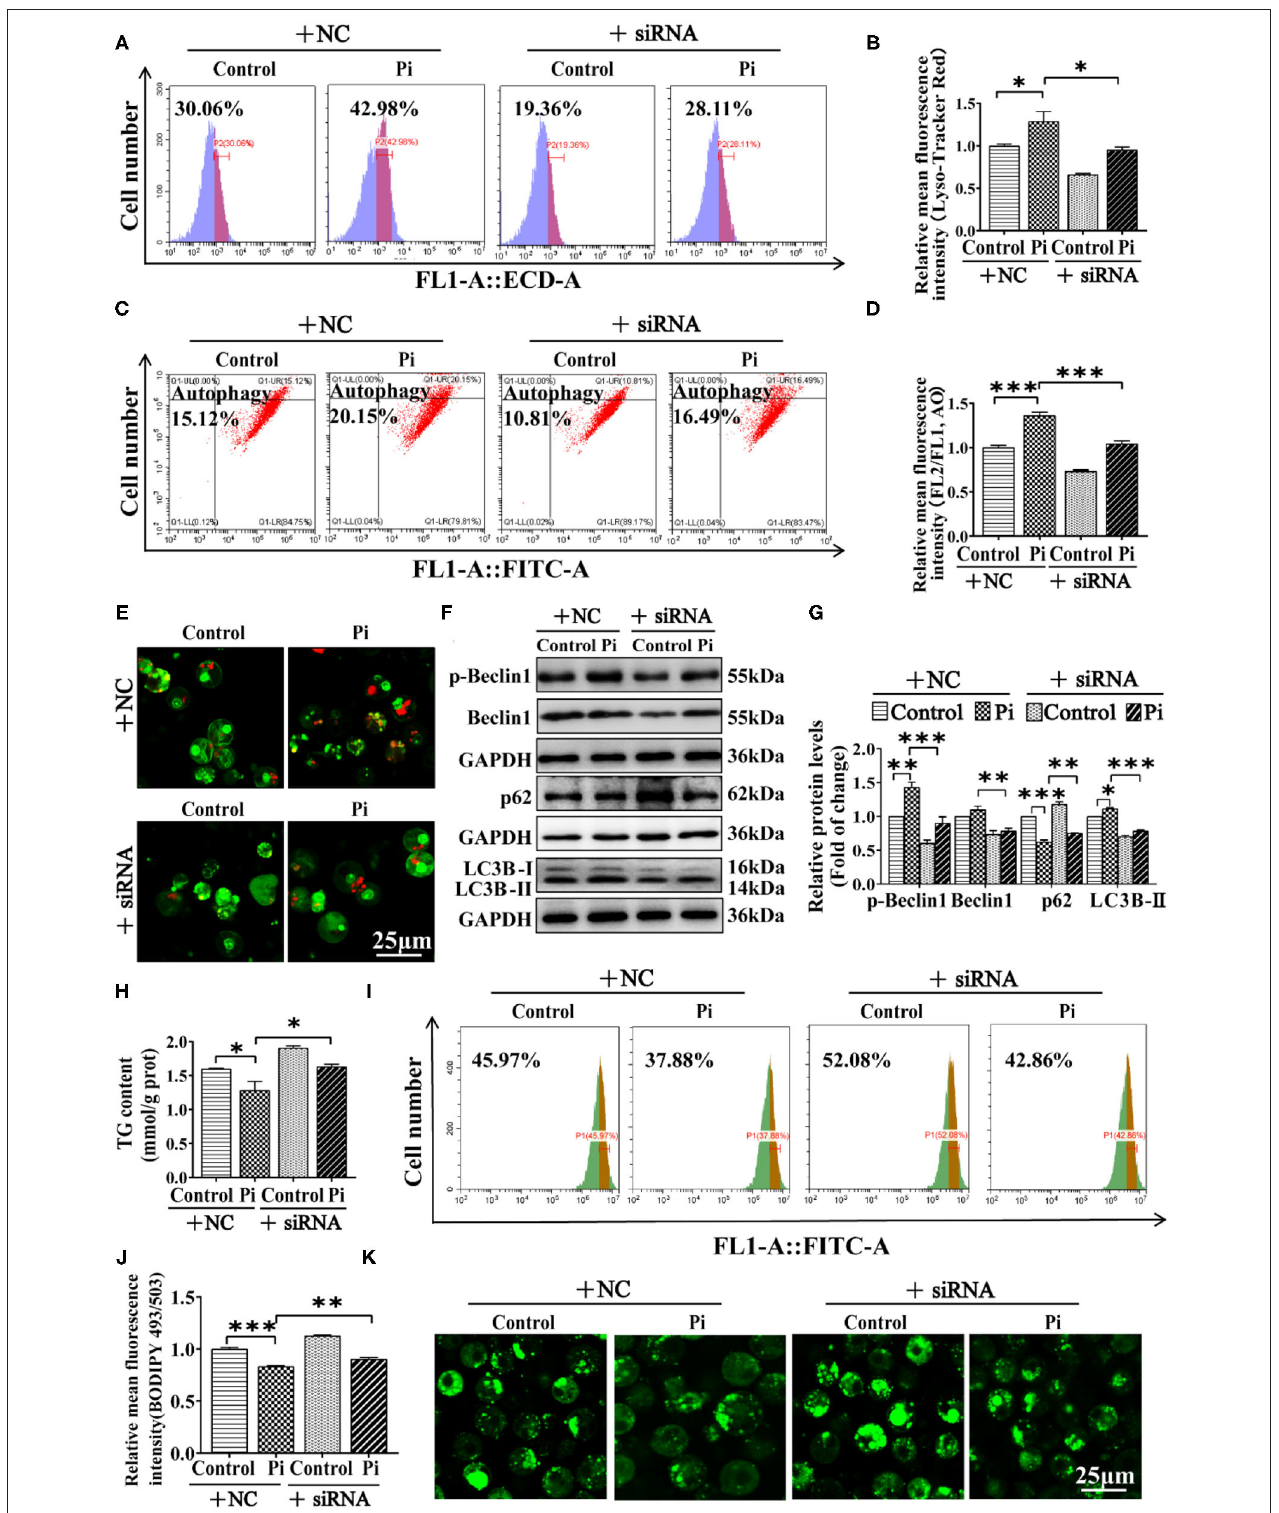
FIGURE 7 | Phosphorus incubation activated lipophagy by triggering Beclin1 phosphorylation to induce lipid degradation in tilapia hepatocytes. Tilapia hepatocytes were incubated with Pi and Beclin1-knockdown experiment for 48h in L-15 medium. (A) The presence of Lyso-Tracker Red-stained autolysosome was